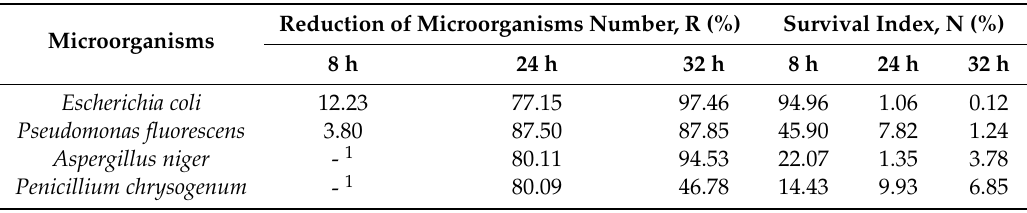
Table 1. Reduction in the number of microorganisms and their survival on PP/SPBS nonwoven. Reduction of Microorganisms Number, R (%) Survival Index, N (%) Microorganisms 8 h 24 h 32 h Escherichia coli Pseudomonas fluorescens Penicillium